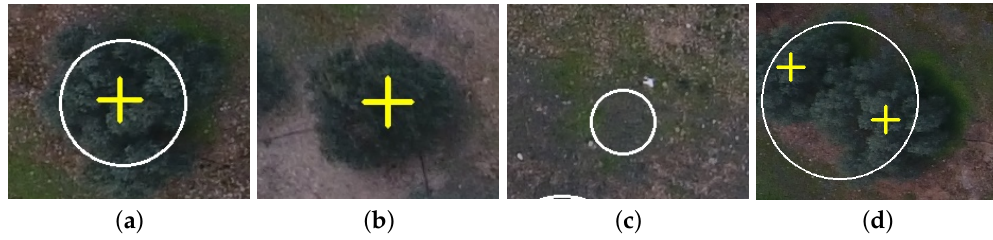
Figure 9. Different associations when matching ground-truth (yellow crosses) and detected trees (white circles). ( a ) One-to-one (TP = 1). ( b ) One-to-zero (FN = 1). ( c ) Zero-to-one (FP = 1). ( d ) Many-to-one (TP = 1, FN =